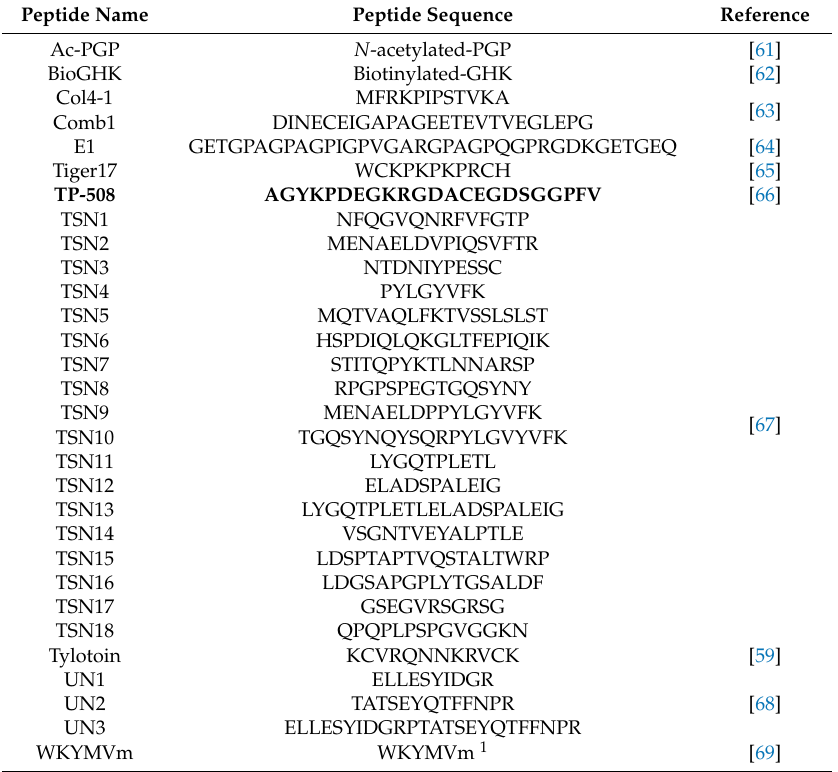
Table 2. Examples of non-antimicrobial peptides presenting wound-healing activity. Peptide sequences are displayed using the one-letter amino acid code, as per the IUPAC-IUBMB Joint Commission on Biochemical Nomenclature